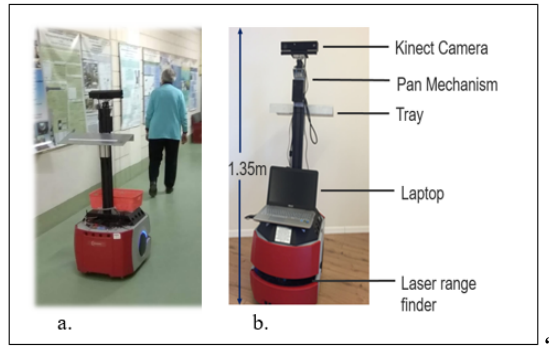
Figure 1: (a) A participant being followed by the robot; (b) Experi- mental platform – Pioneer LX mobile